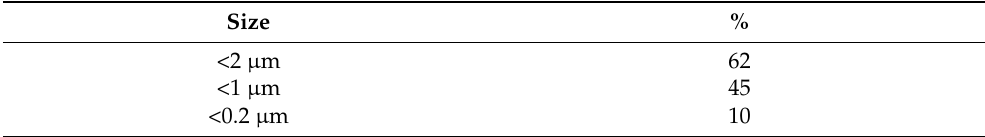
Table 1. CamCoat 80 particle size distribution.